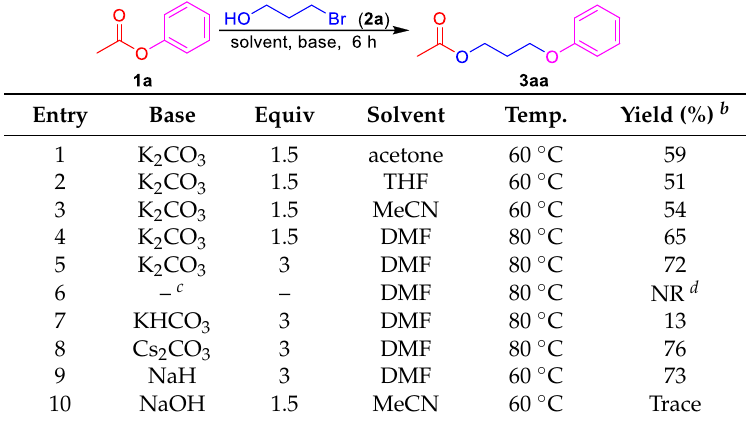
Entry Base Equiv Solvent